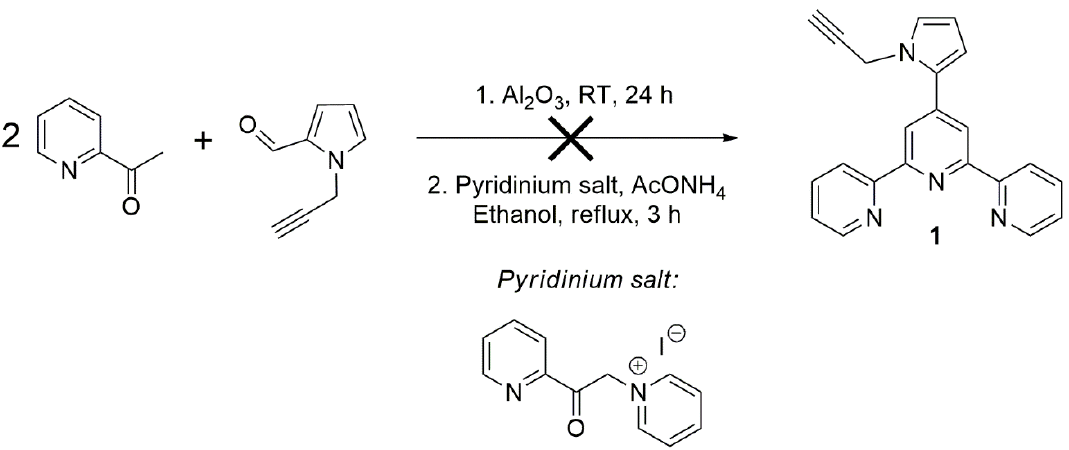
Figure 5. Tentative attempt to obtain compound 1 with an alternative synthetic protocol.